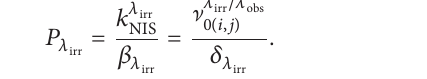
Figure 10: Variation of 𝛽 𝜆 (data from Table